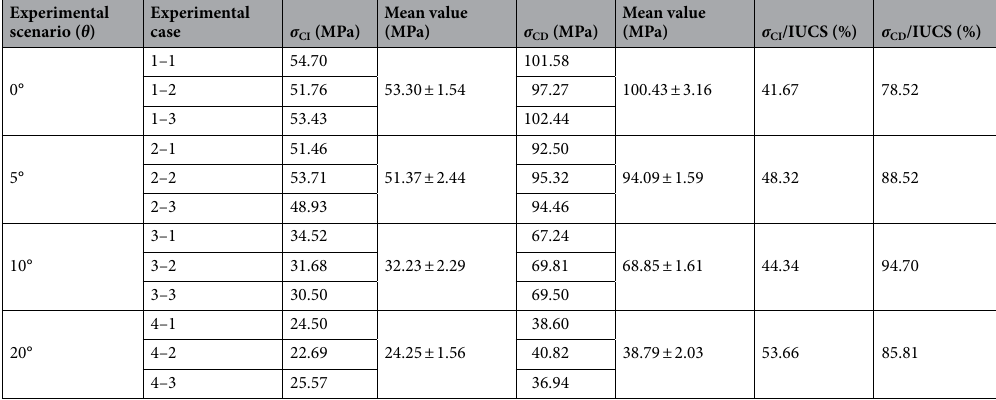
Table 4. CI and CD thresholds determined by AE count and their ratio to corresponding peak compression strength of granite specimen at various inclination angles.